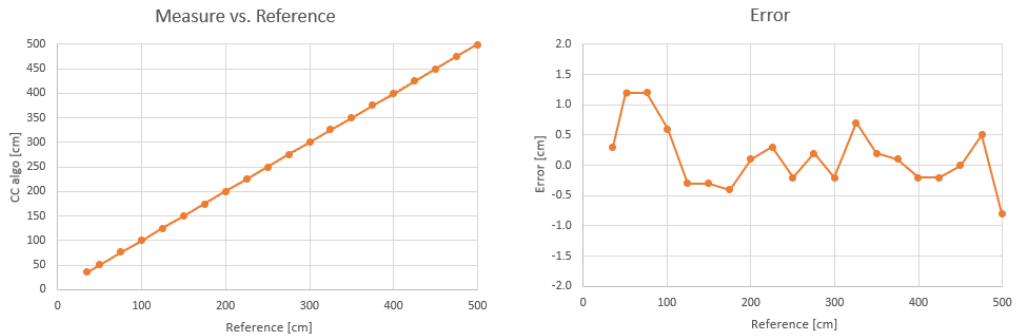
Figure 6. Measured distance vs. reference and its error.